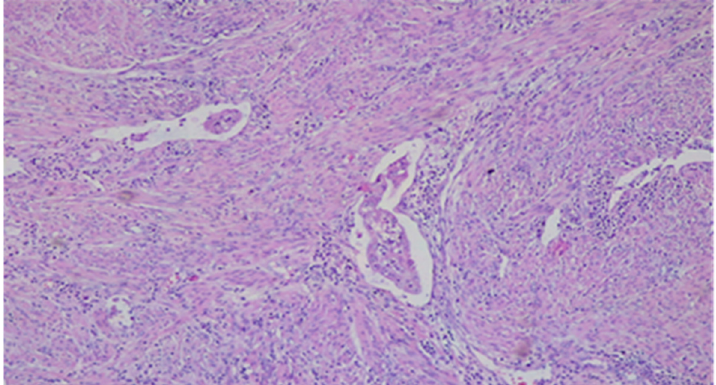
Figure 4. LVI—a single vessel with tumor embolus in the lumen. HE ×